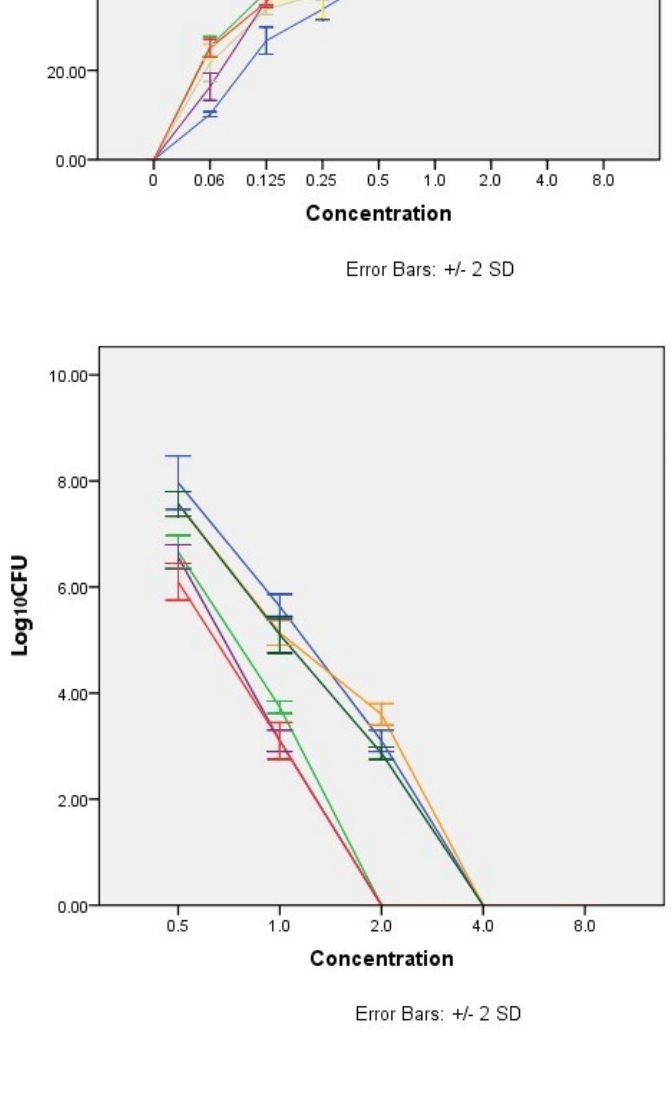
Figure 1. Percentage reduction of XTT metabolic activity of P. aeruginosa (ATCC 25619), S. aureus (ATCC 29213) and K. pneumoniae (ATCC 13883) 24h established biofilms after treatment with different concentrations of C. verum EO and Chlorhexidine digluconate. All error bars represent the ± 2 standard deviations (SD). CV: C. verum leaf oil, CHL: Chlorhexidine digluconate.